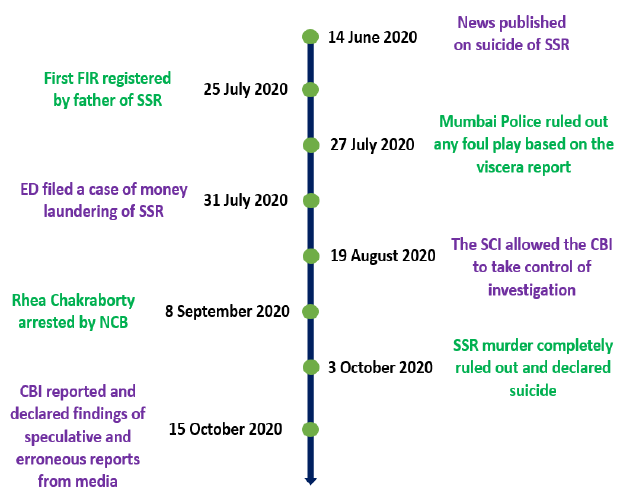
Figure 1. Timeline of significant events related to SSR case. [SSR: Sushant Singh Rajput; FIR: First Information Report; ED: Enforcement Directorate; SCI: Supreme Court of India; CBI: Central Bureau of Investigation; NCB: Narcotics Control